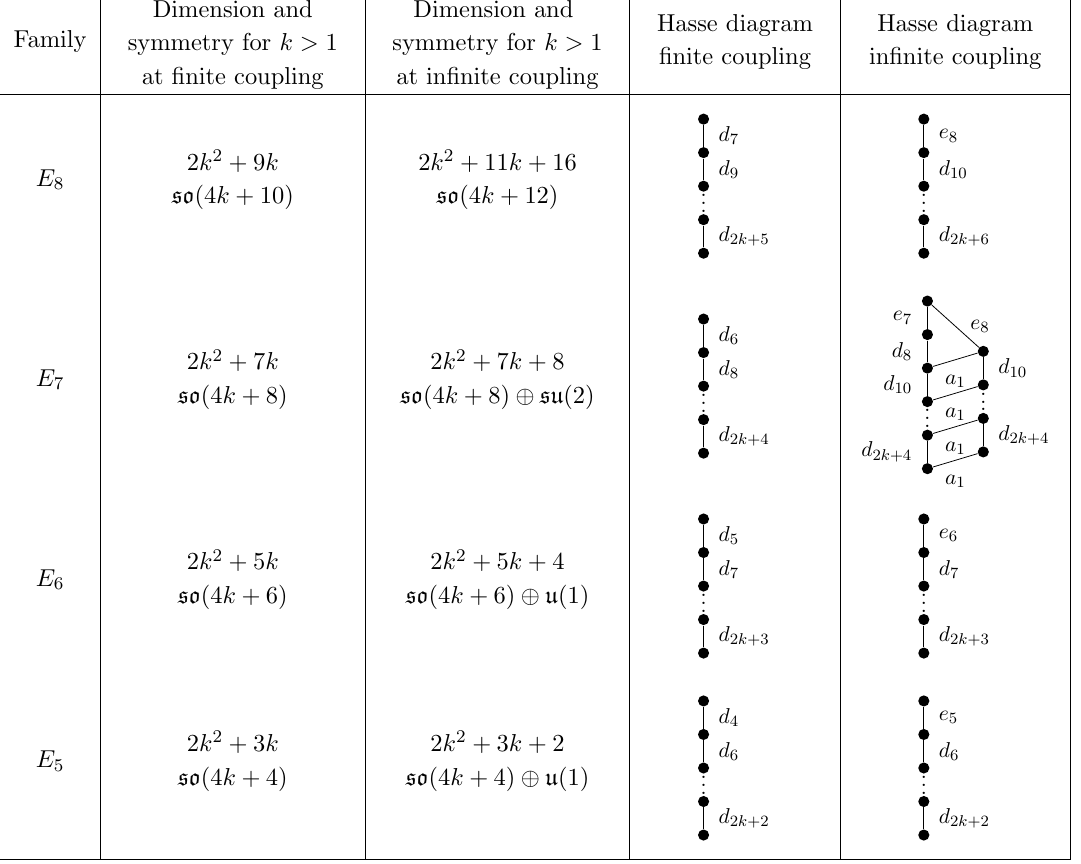
Table 2 . Coulomb branch quaternionic dimension, global symmetry and Hasse diagram for the orthogonal exceptional families, both at (cid:12)nite and in(cid:12)nite gauge coupling. The Hasse